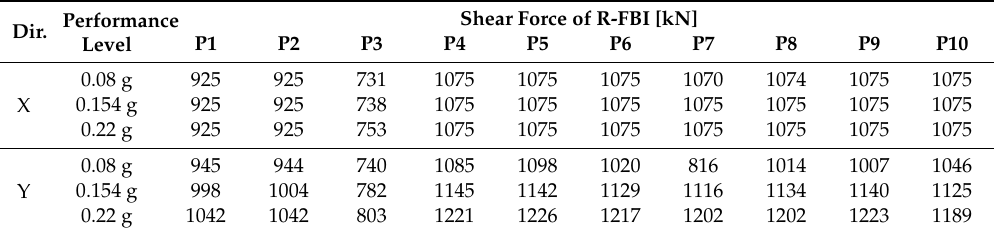
Table 9. R-FBI shear force results using a nonlinear time history response